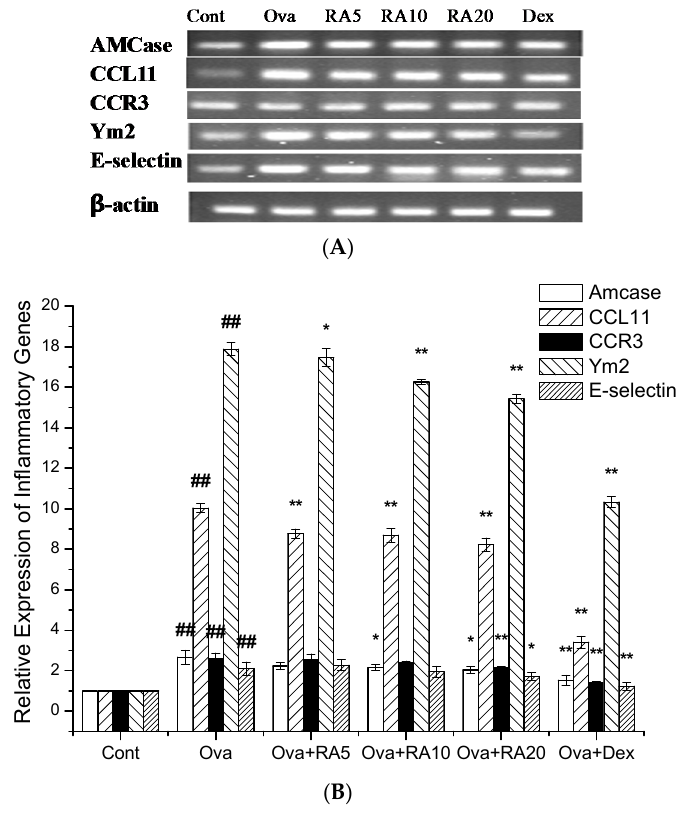
Figure 7. Effects of RA on Ova-induced inflammatory gene expression in the Ova-challenged mice. Lung tissues were collected at 24 h after the last Ova challenge. The PCR products were separated in a 2% agarose gel visualized under ultraviolet light ( A ). The expression levels of mRNA isolated from whole lung extracts were measured by real-time PCR ( B ). The values represent the mean ± SEM of three independent experiments. # p < 0.05, ## p < 0.01 vs. control group; and * p < 0.05, ** p < 0.01 vs. Ova.